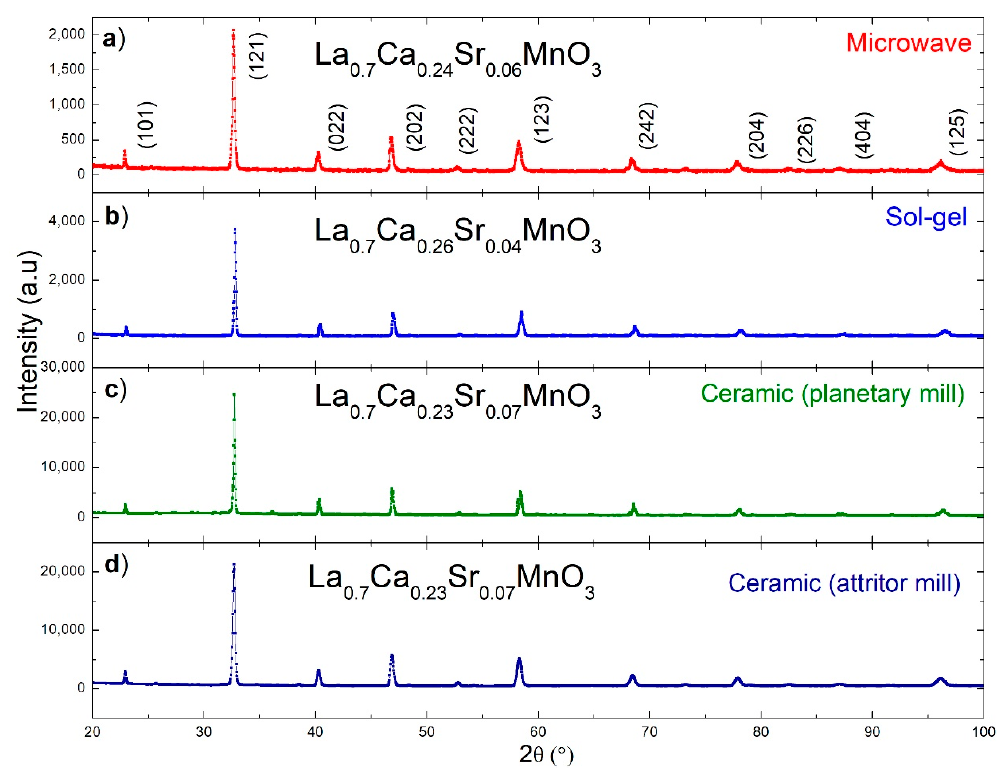
Figure 1. Powder X-ray diffraction patterns of the manganites obtained by different methods: ( a ) microwave-assisted sol-gel Pechini method; ( b ) sol-gel Pechini chemical synthesis; ( c ) solid-state reaction with planetary mill; and ( d ) solid-state reaction with attritor mill.